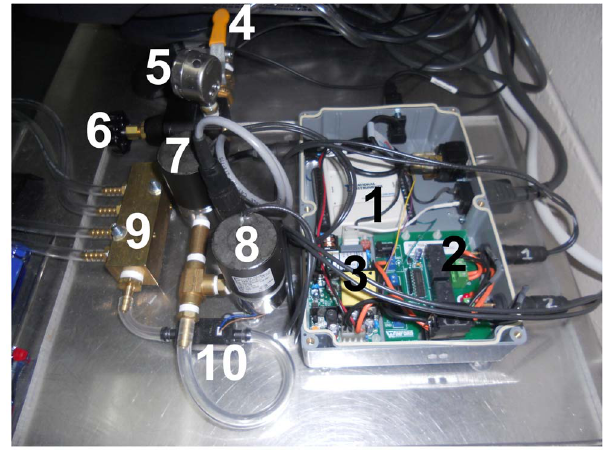
Figure 4. The completed balloon catheter inflation device consists of: the USB interface (1), relay board (2), 24 VDC power supply (3), main pressure valve (4), pressure dial (5), pressure regulator (6), pressurizing solenoid valve (7), venting